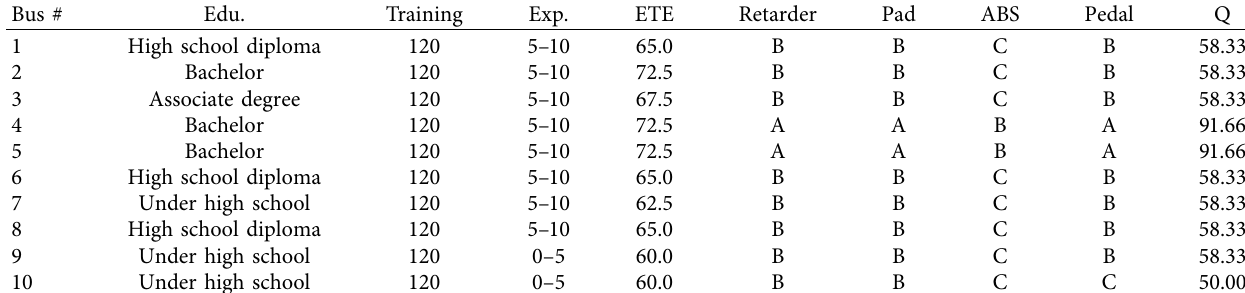
Table 5: Results.